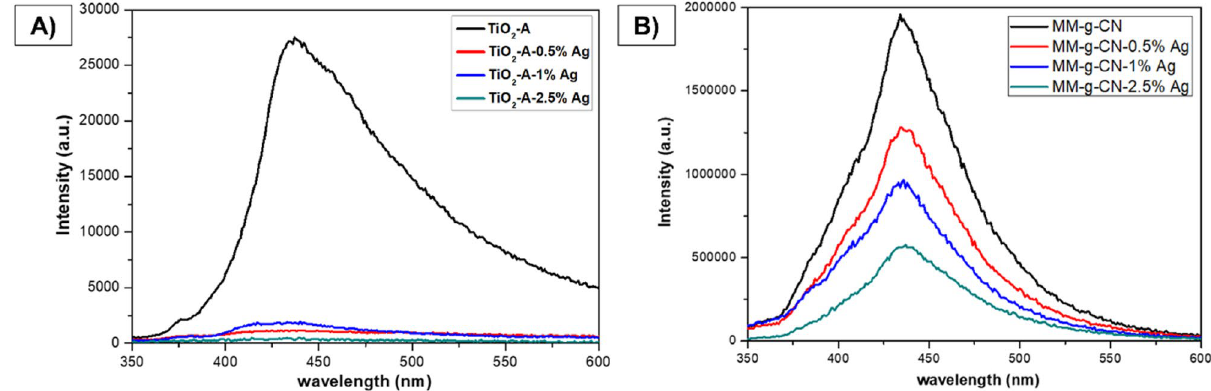
Figure 7. PL spectra of: ( A ) TiO 2 -A-n% Ag and ( B ) MM-g-CN-n% Ag powders.